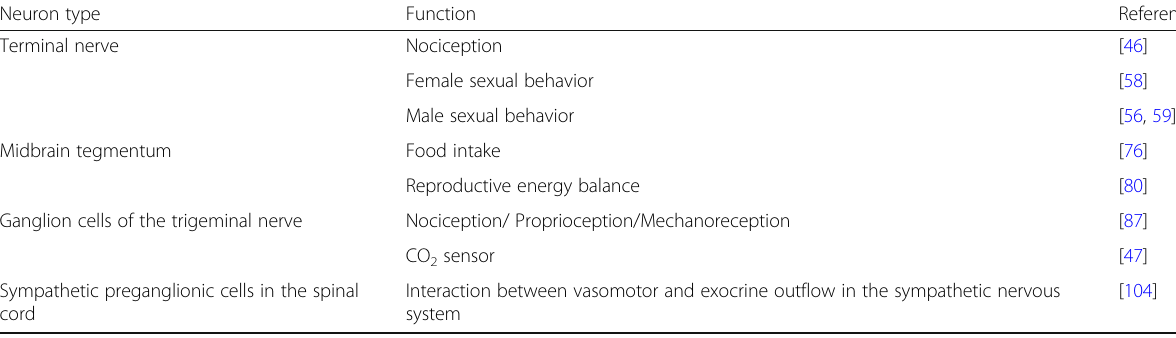
Table 1 Proposed functions of GnRH-expressing neurons in literature Neuron